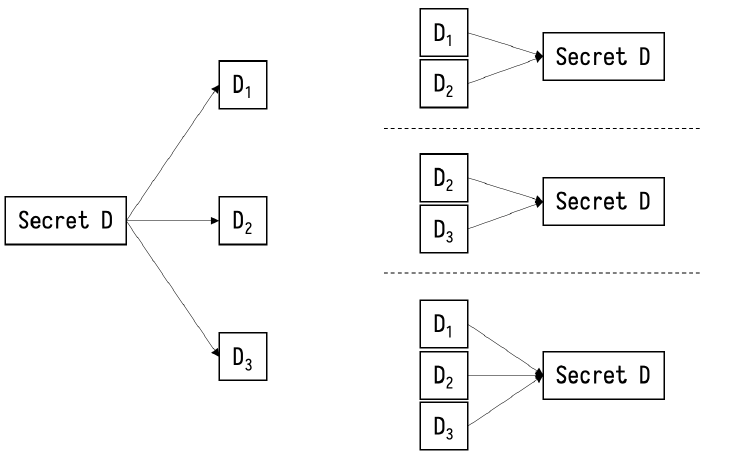
Figure 1. A ( 2,3 ) -threshold secret sharing. Any 2 shares or all 3 shares can reconstruct the original